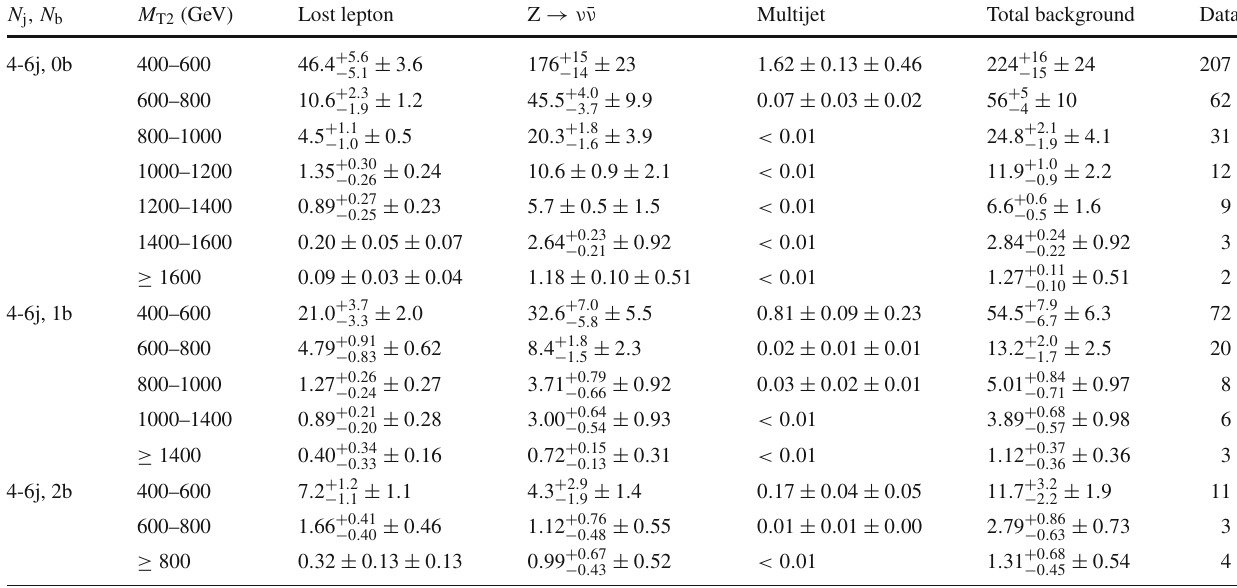
limited size of data control samples and Monte Carlo samples), and the second is